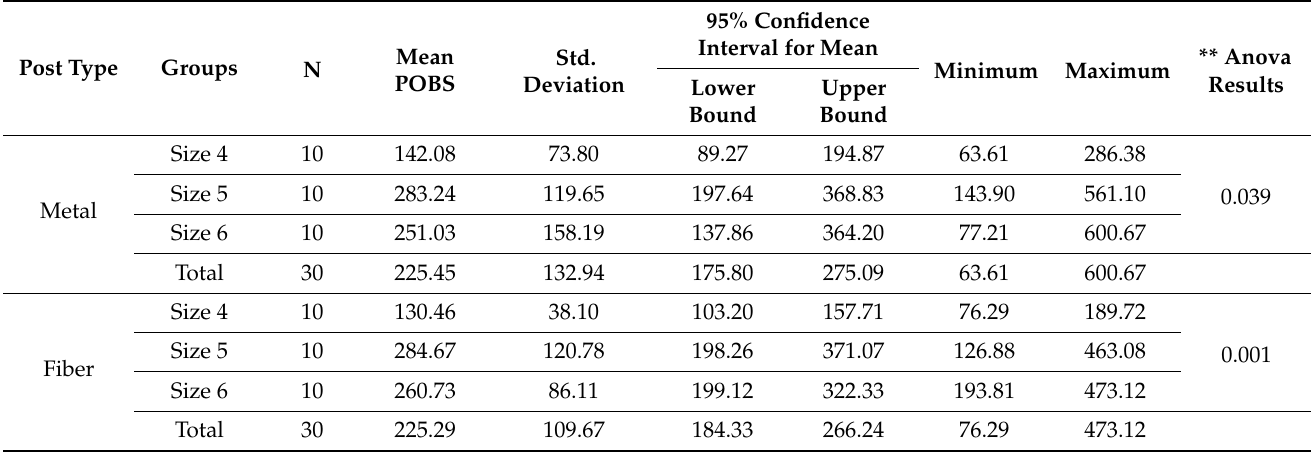
Table 2. Descriptive statistics for the *PBS of the tested groups.